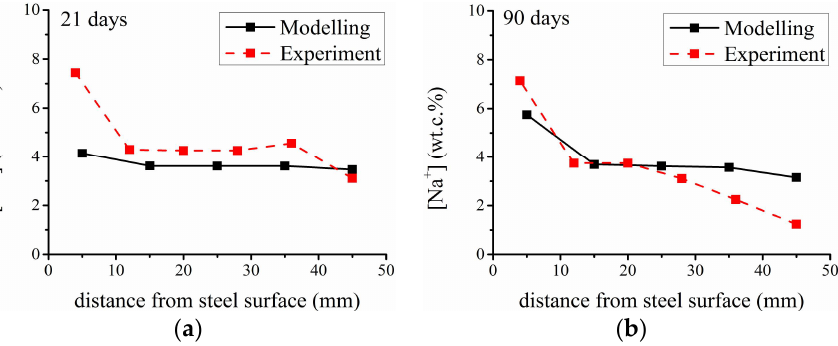
Figure 9. Comparison of the concentration profiles of Na + between modelling and the experimental test with D Na = 3 × 10 −12 m 2 /s after the electrochemical treatment of ( a ) 21 days; ( b ) 90 days.